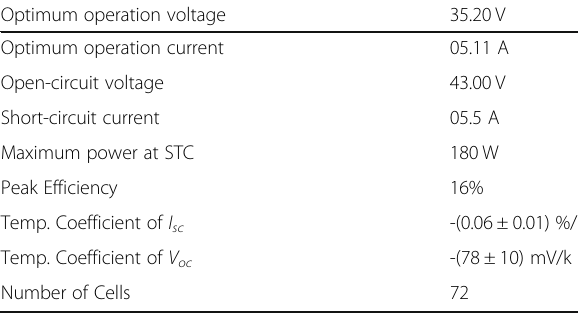
Table 1 Parameter values of YHM180-36 M PV